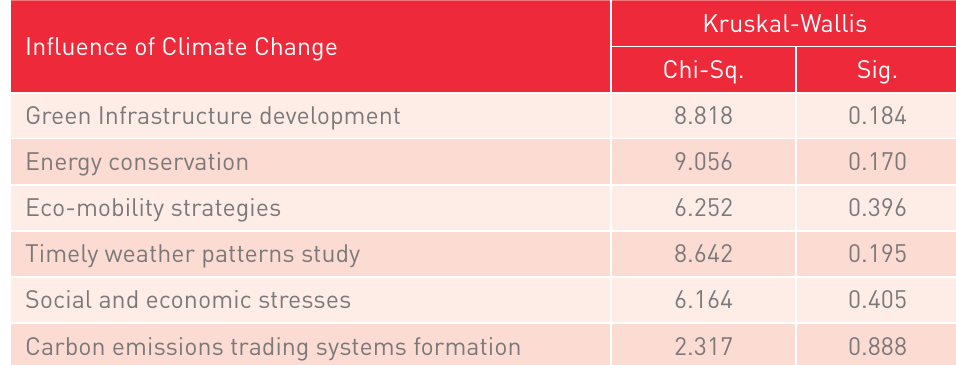
Kruskal-Wallis H-Test for Influence of Climate Change on Resilience Influence of Climate